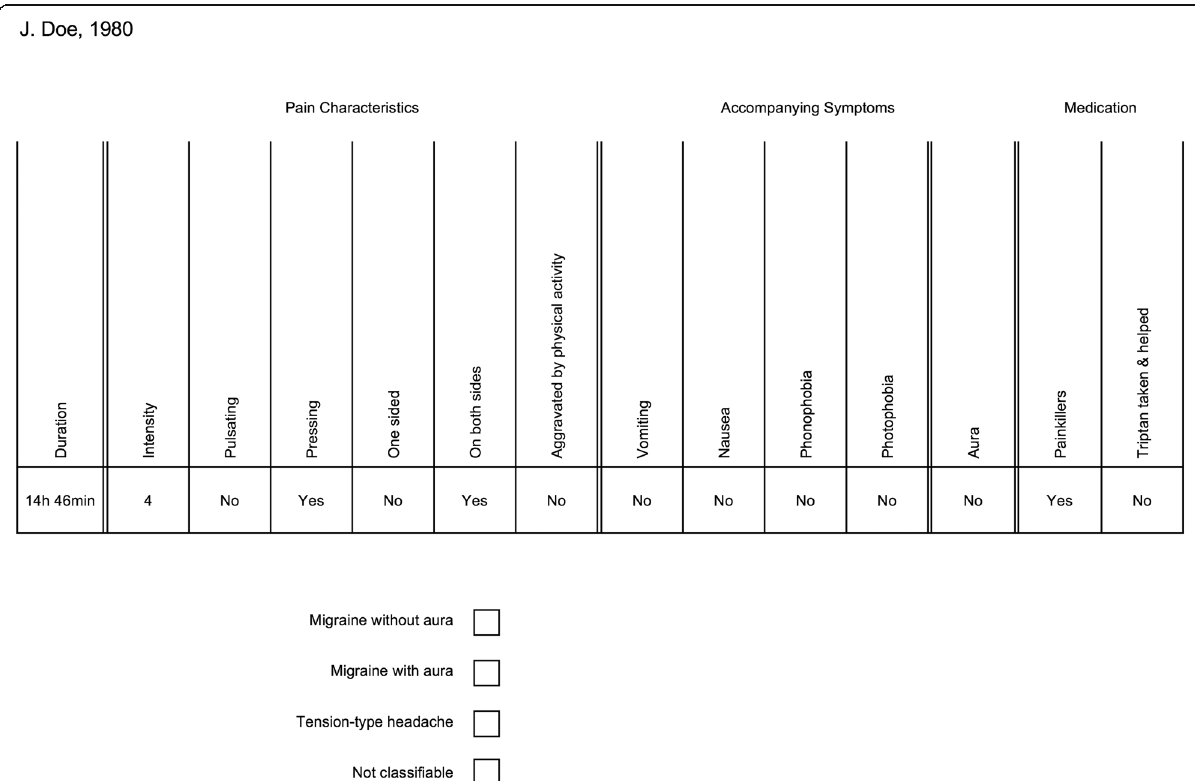
Fig. 3 Generic single headache diary entry as seen by the